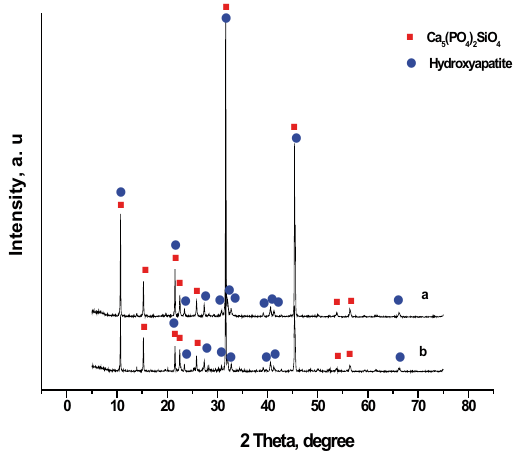
Figure 6. XRD obtained for G/S hybrid materials with 25:75 wt.% (a) and 75:25 wt.% (b) after immersion in 1.5 SBF for